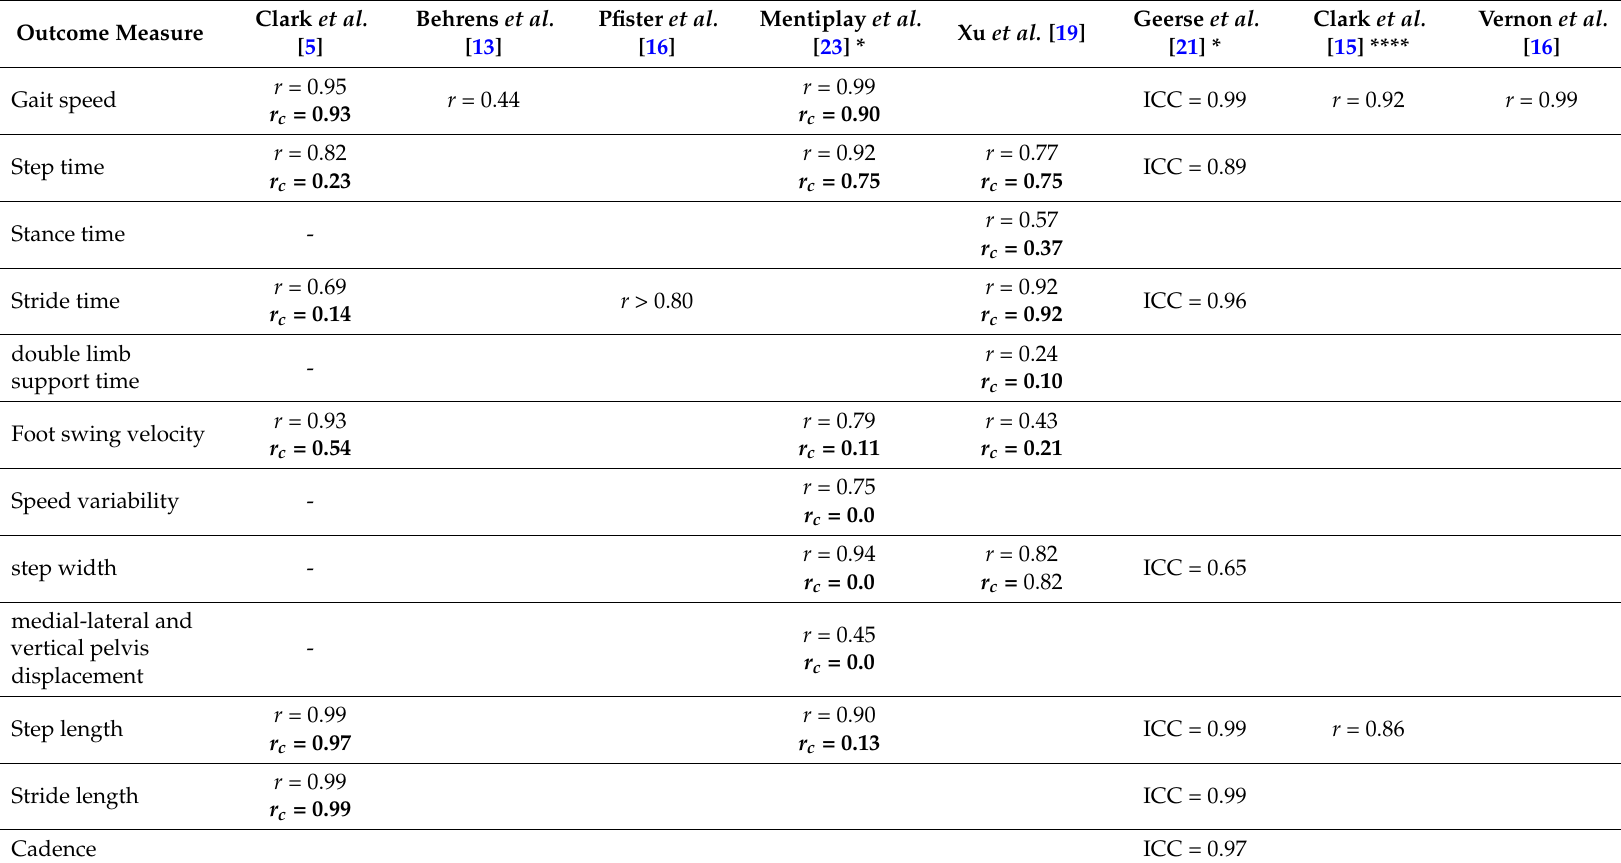
Table 3. Correlation coefficient ( r ), Concordance correlation coefficients ( r c ), and Intraclass correlation coefficient (ICC) of gait parameters measured by Kinect and gold standard (Spatiotemporal